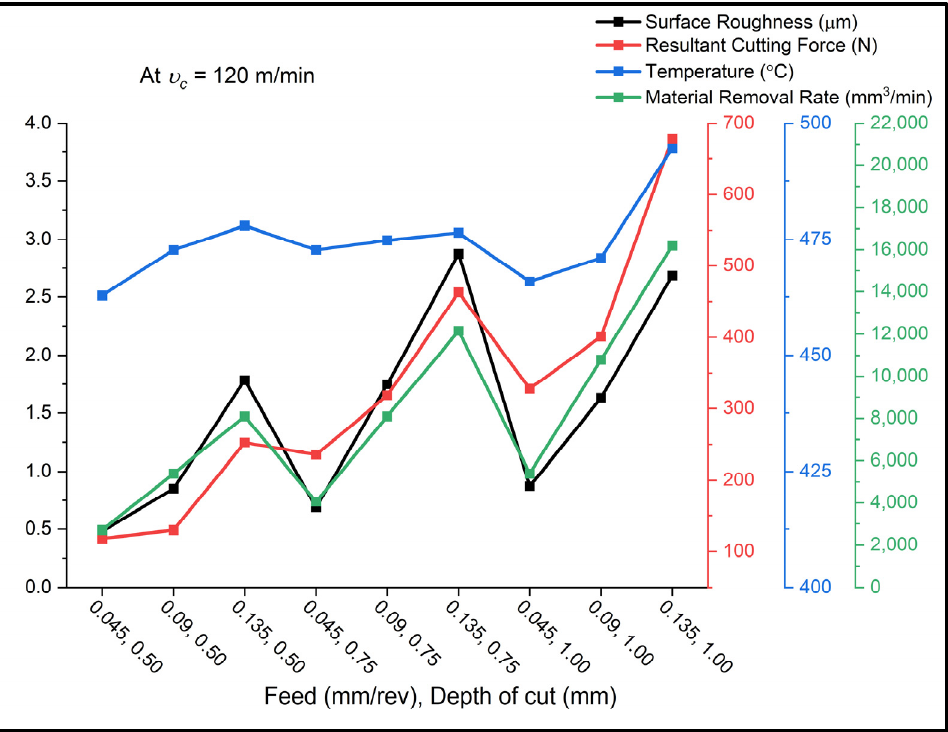
Figure 11. The experimental results at cutting speed = 120 m/min.